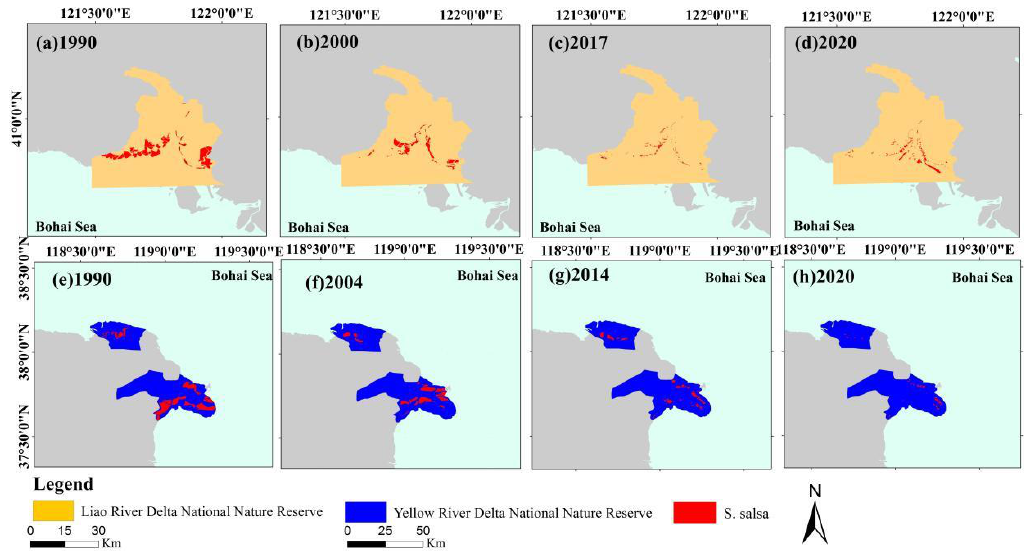
Figure 8. Dynamic changes in S. salsa in NNR (the administrative region map in the 1990s): ( a – d ) Liao River Delta NNR in 1990, 2000, 2017, 2020, respectively. ( e – h ) Yellow River Delta NNR in 1990, 2004, 2014, 2020, respectively.